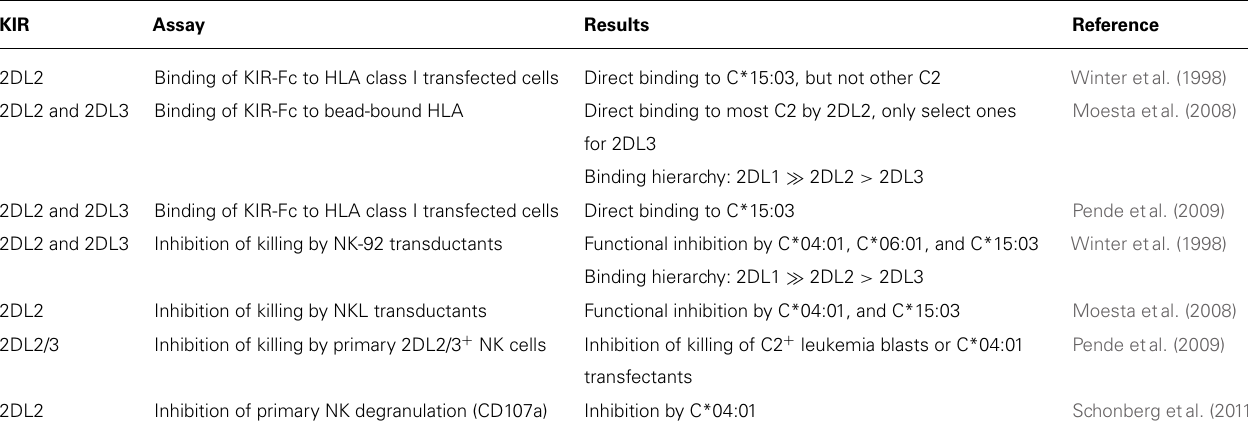
Table 3 | KIR2DL2 and KIR2DL3 interactions with HLA-C2. KIR Assay Results Reference